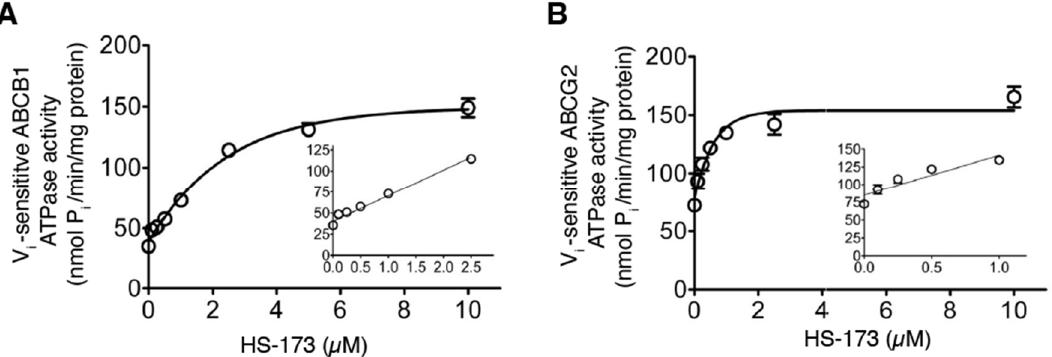
Figure 6. HS-173 stimulates the ATPase activity of ABCB1 and ABCG2. The e ff ect of HS-173 (0–10 µM) on the vanadate (Vi)-sensitive ATP hydrolysis of ( A ) ABCB1 and ( B ) ABCG2, determined by endpoint Pi assay, as described previously [37,57]. Points, mean from a minimum of three independent experiments; bars, SEM.